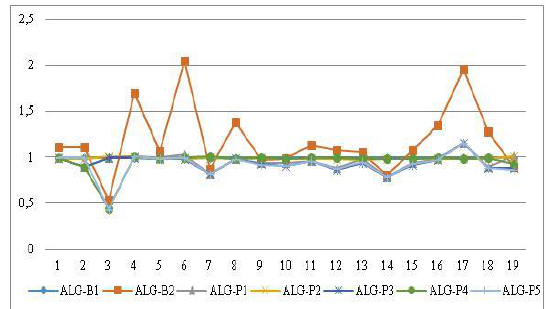
Figure 7. Relative comparison of the solution